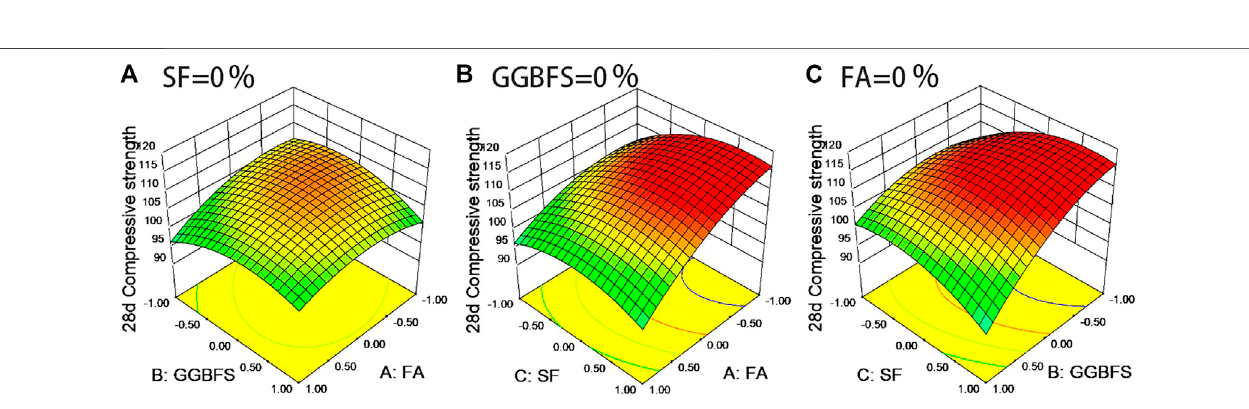
FIGURE 14 | The combined effect of SCMs on 28 d compressive strength of nano-silica modi fi ed cement-based paste.